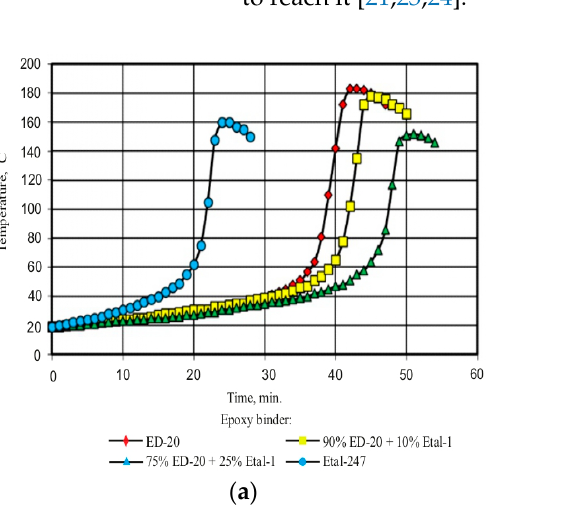
Figure 3. Kinetic curves of temperature increase by compositions of epoxy mixtures based on PEPA ( a ) and Etal ‐ 45M ( b ) hardeners during curing.